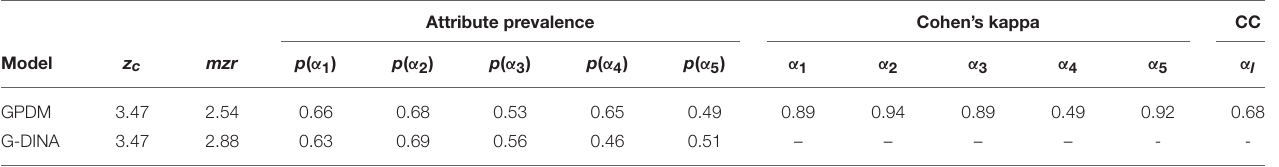
TABLE 5 | Fitting and attribute estimation for the PISA data. Attribute prevalence Cohen’s kappa CC